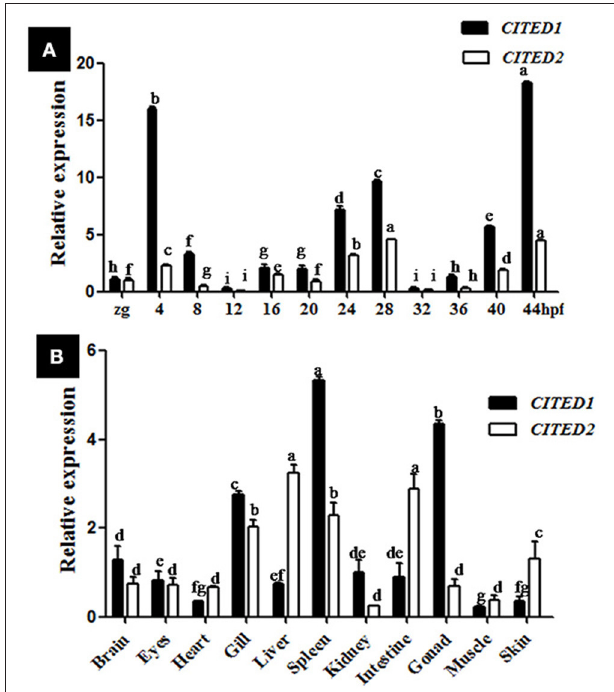
FIGURE 3 | Expression of CITED1 / -2 mRNAs during embryogenesis (A) and in adult tissues (B) of blunt snout bream. The relative expression was analyzed by q RT - PCR. The CITED1 / -2 copy numbers were normalized to the amount of 18S mRNA. The results are given as mean ± SE for separate samples ( n = 5). Columns marked with different letters are significantly different ( p < 0.01). Zg, zygote; hpf, hours